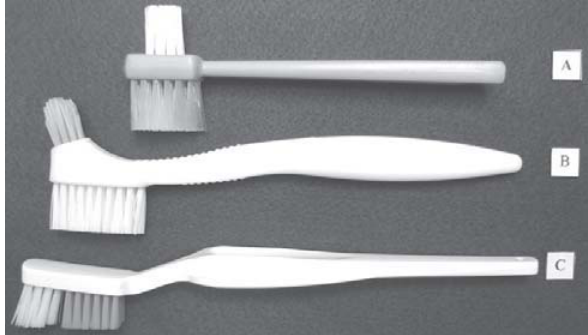
FIGURE 1- Denture brushes: A- Bitufo; B – Medic Denture C –